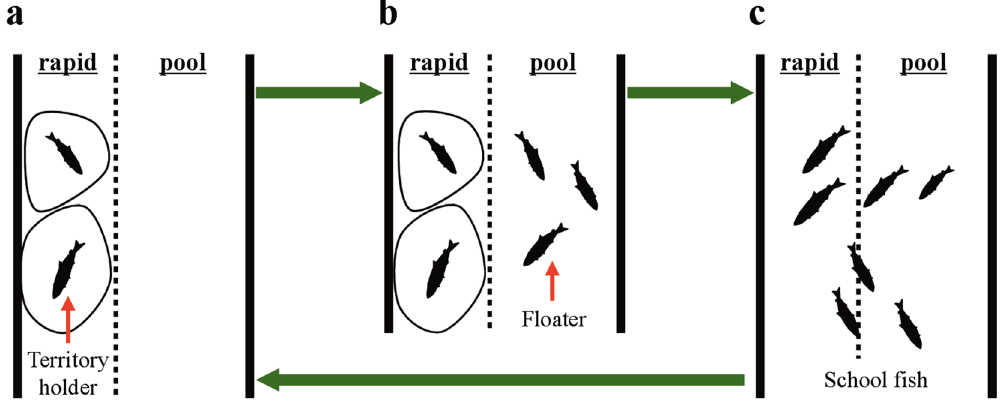
Figure 3. Breakdown and formation processes of territoriality. As the proportion of fish increases, the phases transit as a → b → c. ( a ) In this Th-phase, all fish can hold their own territories in rapids at low proportion, and some territory sites are not occupied. ( b ) In this (Th + Fl)-phase (coexisting phase), when the population size exceeds the territory capacity, newcomers cannot form territories and become floaters in pools. ( c ) In this Sc-phase, as the proportion of fish further increases and exceeds the critical limit, all fish give up their own territories and form a school. In contrast, when the proportion of fish decreases, the phases directly transit as c → a. In other words, when the proportion falls below the critical limit, territories are directly reformed from a school. In contrast to the increasing process, the coexisting phase does not appear in the decreasing process.